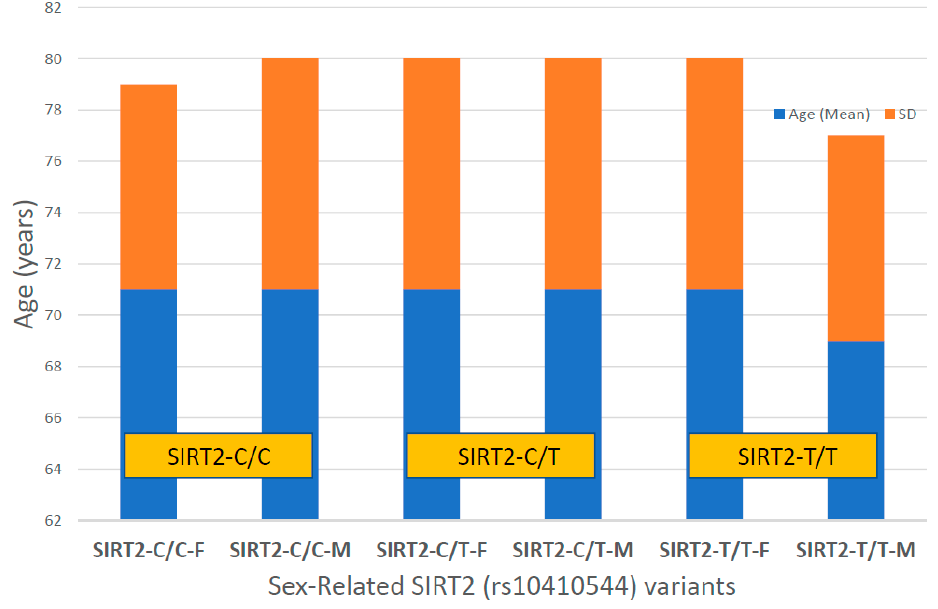
Figure 6. SIRT2 -related differences of age at onset in Alzheimer’s disease.